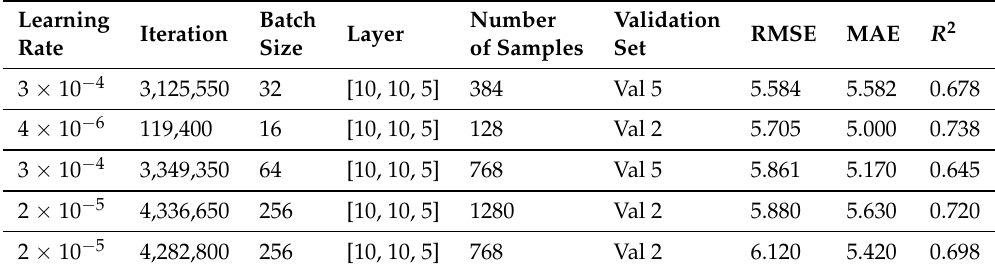
Table 4. Top 5 results with varying